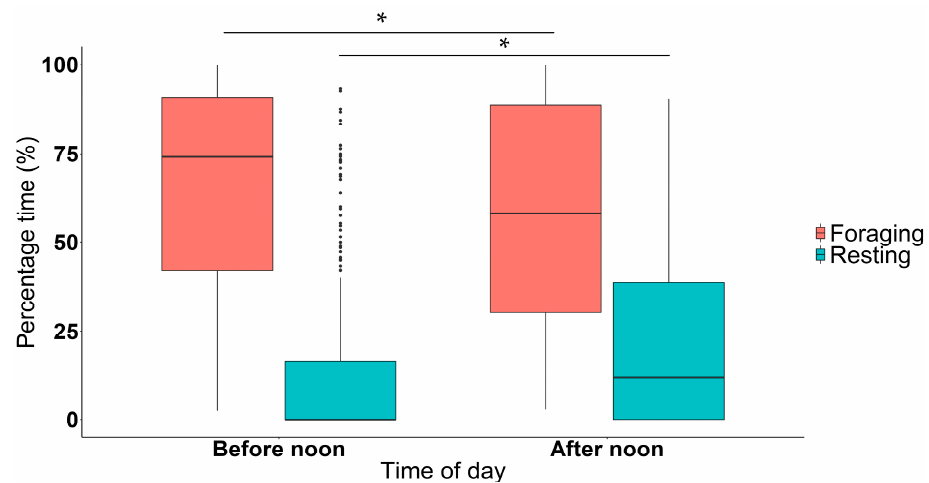
Figure 3. Boxplot depicting the percentage time (%) spent foraging and resting according to time of day. Number of observations = 428. * Indicates statistically significant differences between groups.